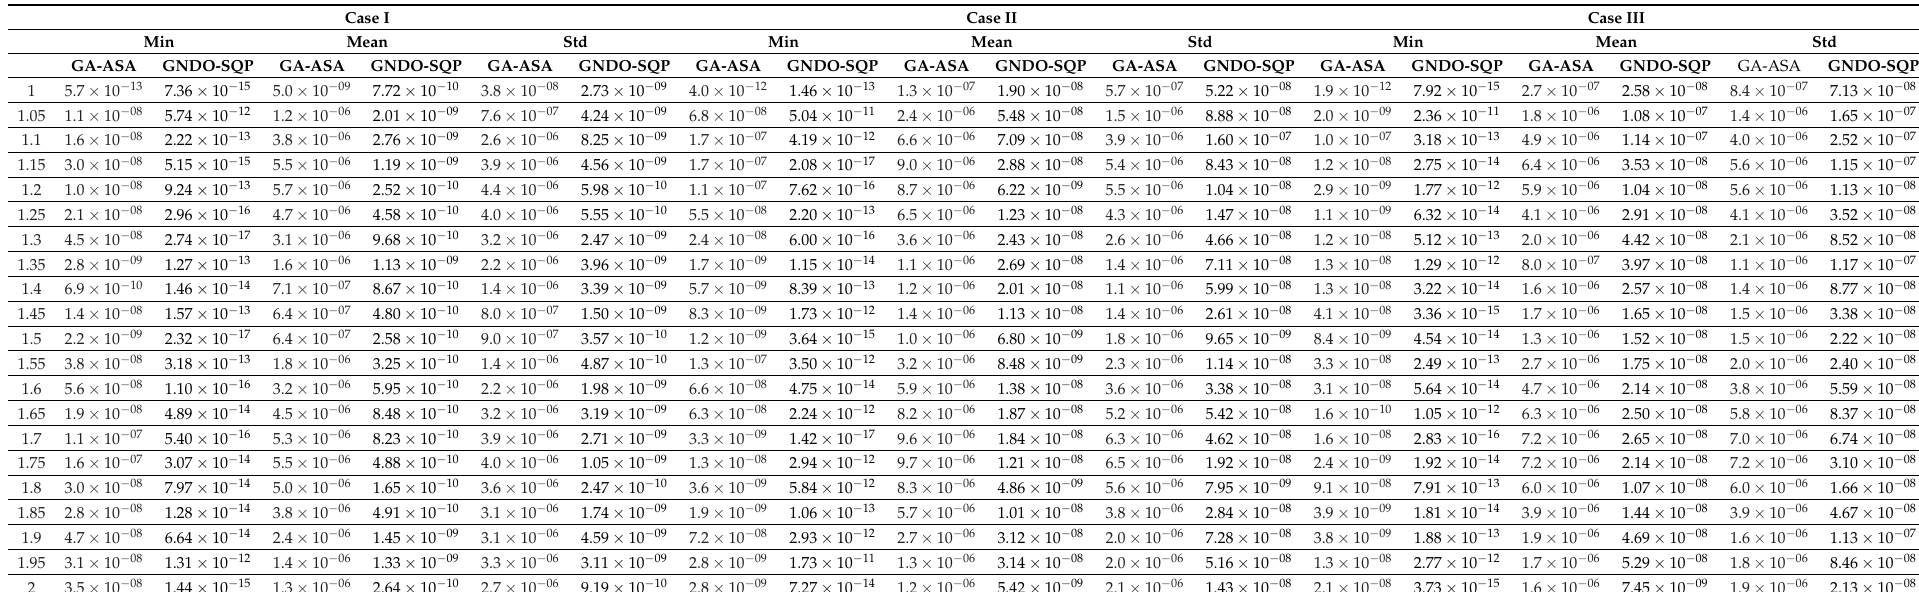
Table 11. Statistical analysis of the results obtained by the LNN-GNDO-SQP algorithm, GA-ASA technique on the 21 steps within the interval [ 1 2 ] , It is evident that LNN-GNDO-SQP is superior in accuracy and stability. Three cases of drainage problem are considered based on variations in S t .